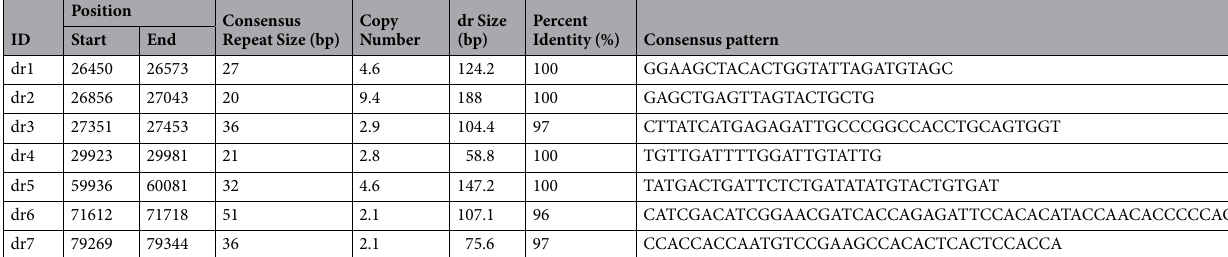
Table 2. Direct repeat predictions within the HgNV genome. dr = direct repeat. Tandem repeat alignment score of > 100.